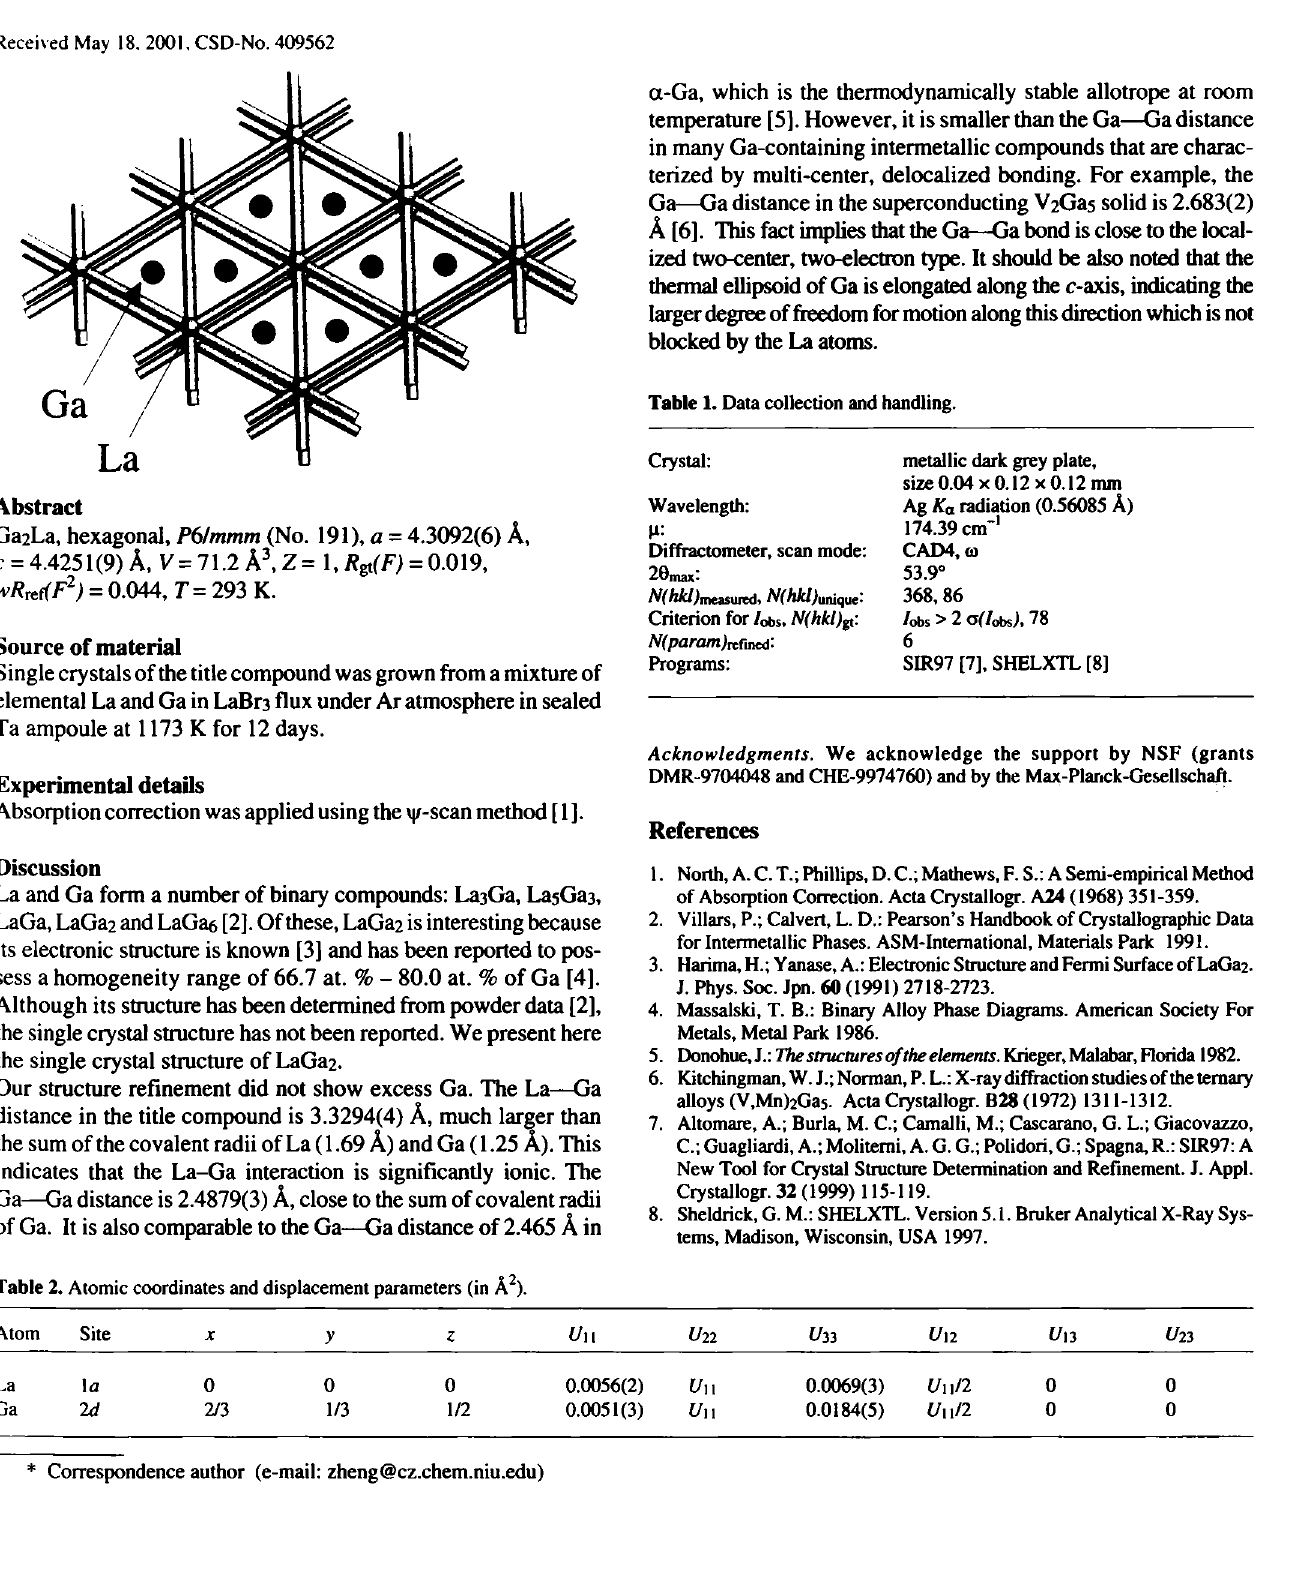
Table 2. Atomic coordinates and displacement parameters (in Ä 2